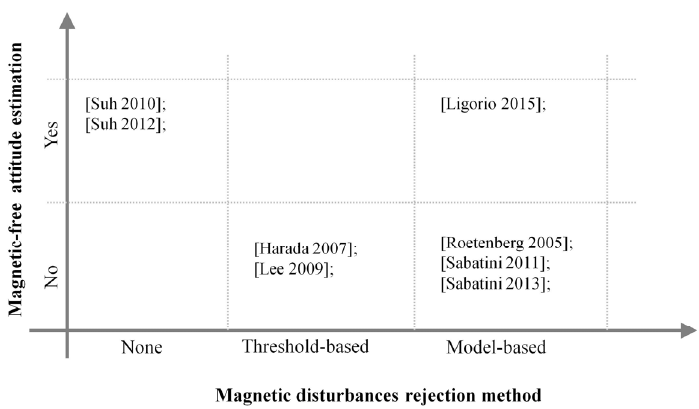
Figure 2. The orientation estimator classification scheme proposed in this paper. The most popular approaches to deal with the magnetic disturbances are placed within this scheme.